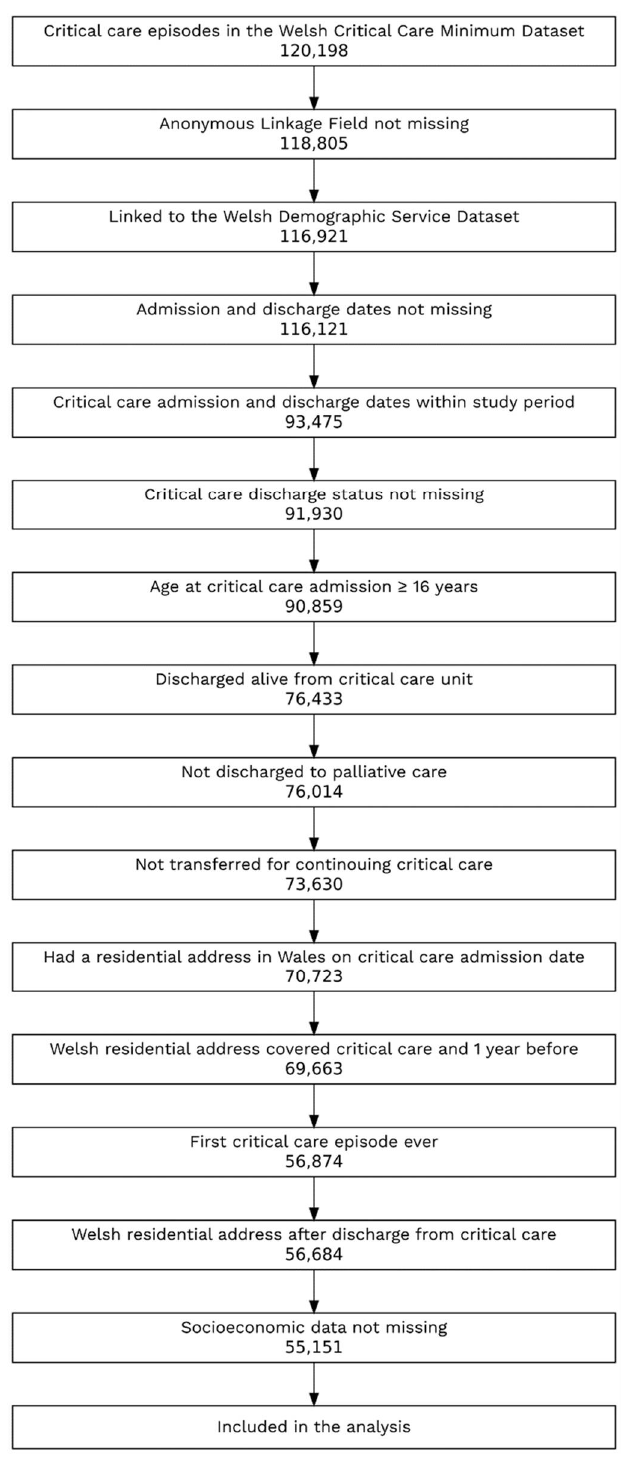
Figure 1. Cohort